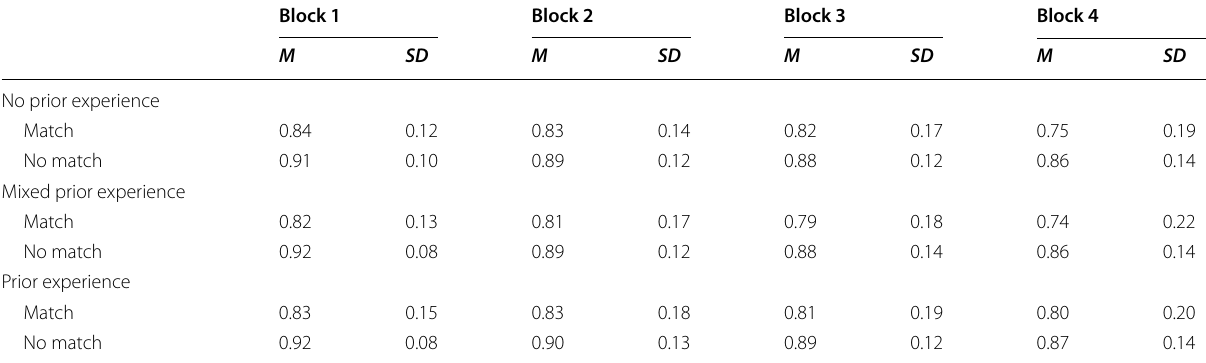
Table 4 Ongoing task accuracy across blocks by experience condition in Experiment